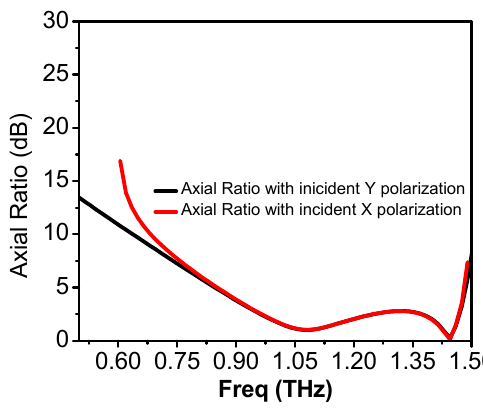
Figure 5. Axial ratio for the transmitted wave.